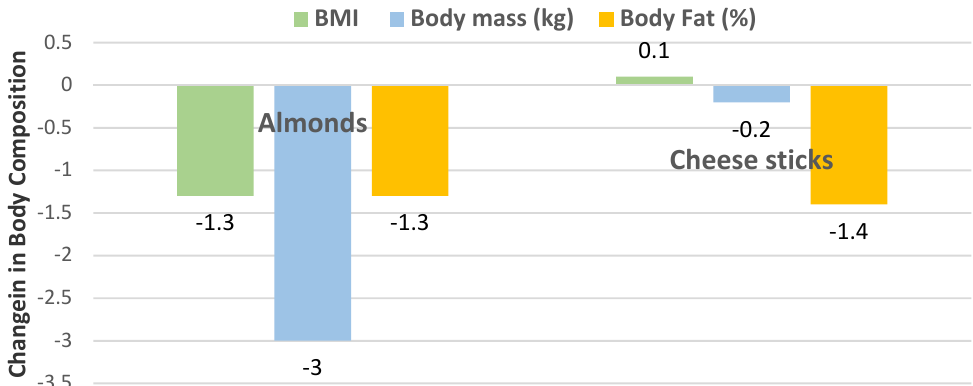
Figure 6. Effects of 5 servings per week of almonds or cheese sticks on body mass and composition parameters from baseline to 12 weeks in obese individuals with T2 diabetes (almonds BMI p = 0.047, body mass p = 0.083, and body fat p = 0.853) compared to cheese sticks [39].